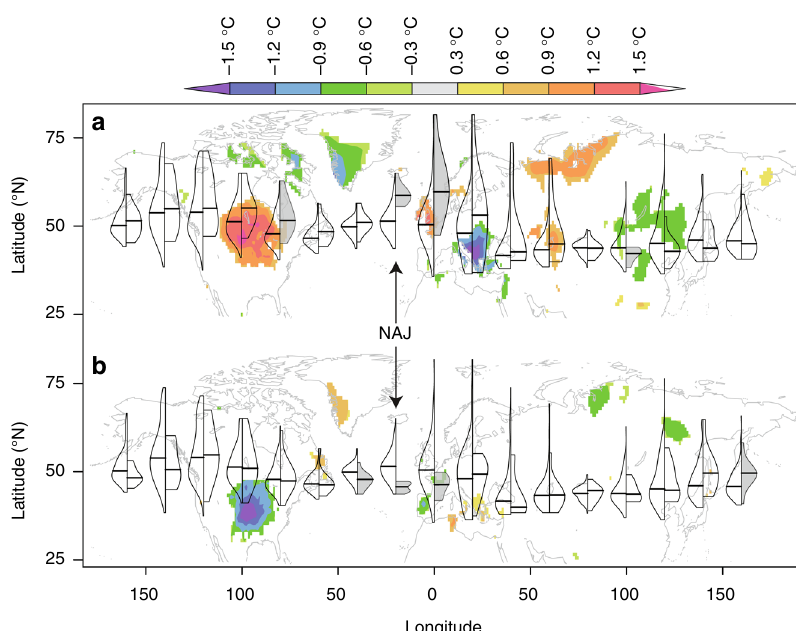
Fig. 1 Latitudinal position of the August Northern Hemisphere Jet. Left wings of the violins represent the August Northern Hemisphere Jet latitudinal position distribution over the instrumental period (1920 – 2012) for 20° longitudinal slices. Right wings represent distribution during anomalous years when the North Atlantic Jet (NAJ; 10 – 30°W) latitudinal position exceeded 1 stdev northwards ( a ) or southwards ( b ). Gray shading indicates signi fi cant differences between the left and right distributions (one-sided Kolmogorov – Smirnov test; p < 0.05). Background map shows August surface temperature anomalies (°C; CRUTEM3.21 60 ) composited over the anomalous years. Composite maps were created in R with color palette adapted from the KNMI Climate Explorer